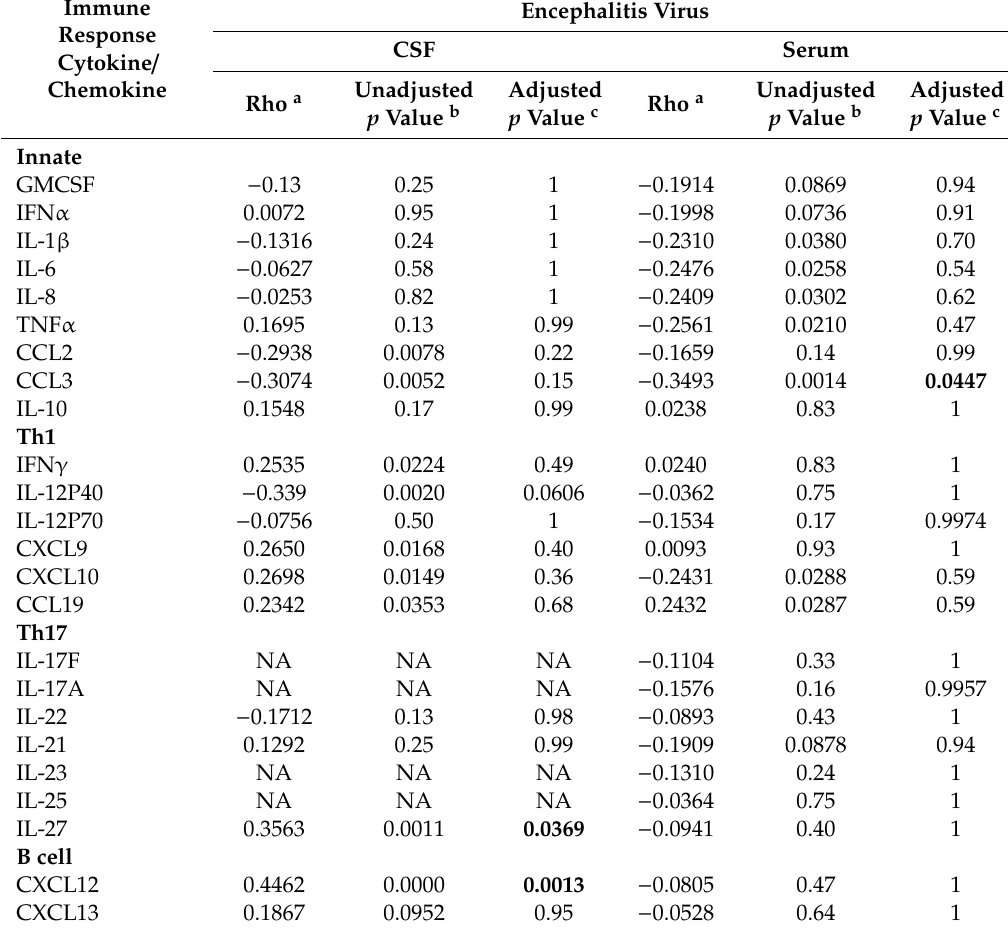
Table 5. Correlation of Cytokine and Chemokine Levels and the Levels of IgG Antibodies against Tick-borne Encephalitis Virus in Cerebrospinal Fluid or